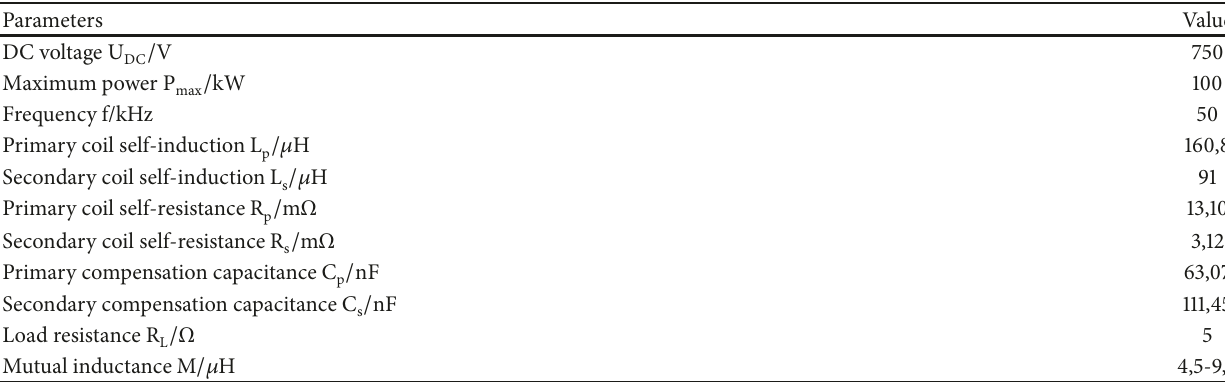
Table 3: System simulation